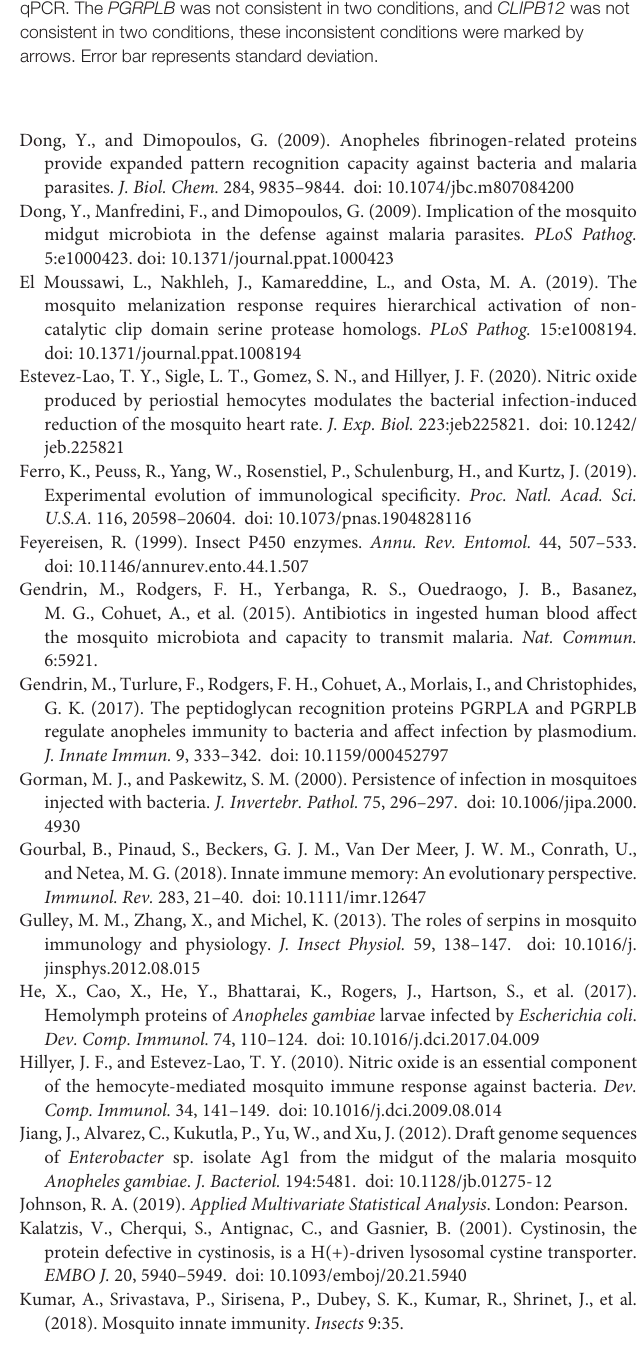
positive with respective bacterial DNA. No non-specific amplifications occur. Supplementary Figure 2 | The expression patterns of five genes were compared between RNA-seq and qPCR. The data were presented as fold change. In the Enterobacter challenged mosquitoes, fold changes of (EP-EI)/(NP-EI) and (SP-EI)/(NP-EI) were presented. In the Serratia challenged mosquitoes, fold changes of (SP-SI)/(NP-SI) and (EP-SI)/(NP-SI) were presented. In most of the six conditions, the gene expression patterns were comparable between RNA-seq and qPCR. The PGRPLB was not consistent in two conditions, and CLIPB12 was not consistent in two conditions, these inconsistent conditions were marked by arrows. Error bar represents standard deviation.